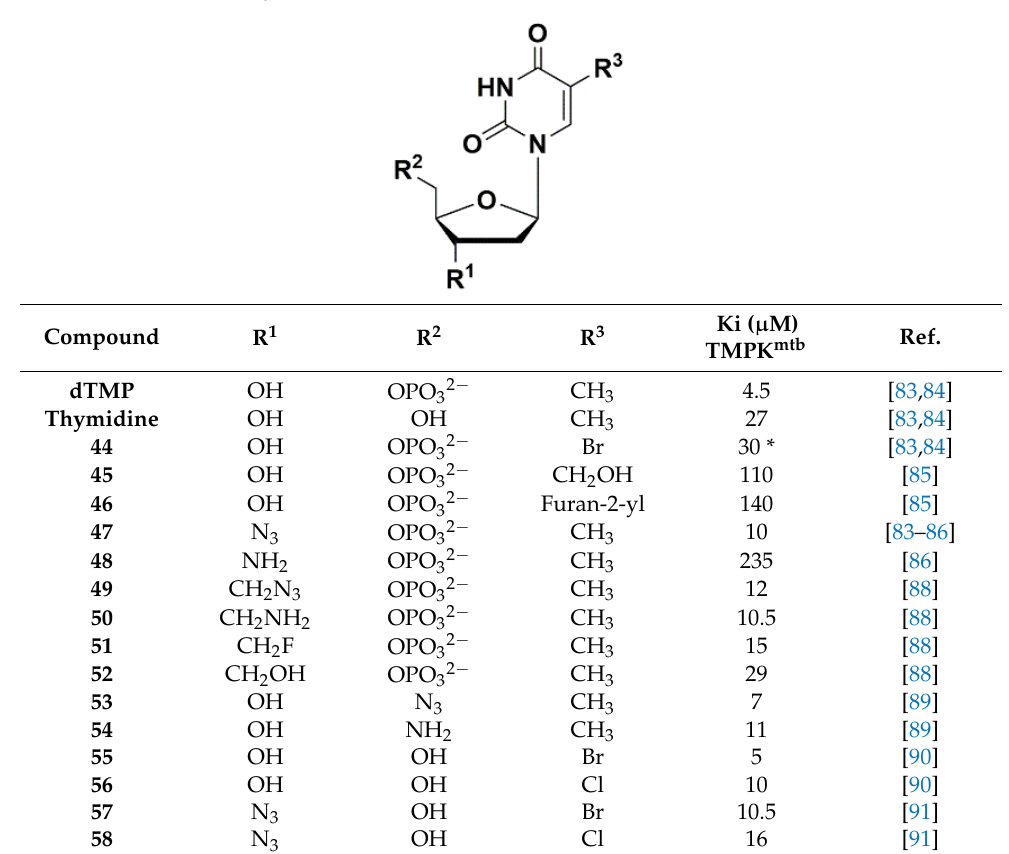
Table 1. Interaction of thymidine derivatives with TMPK mtb .